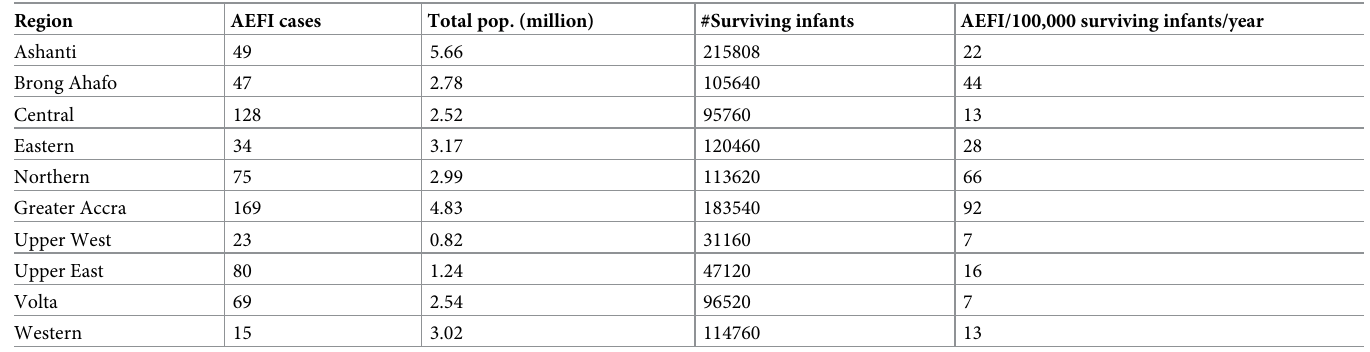
Table 3. Regional performance on AEFI reporting in Ghana, 2018.